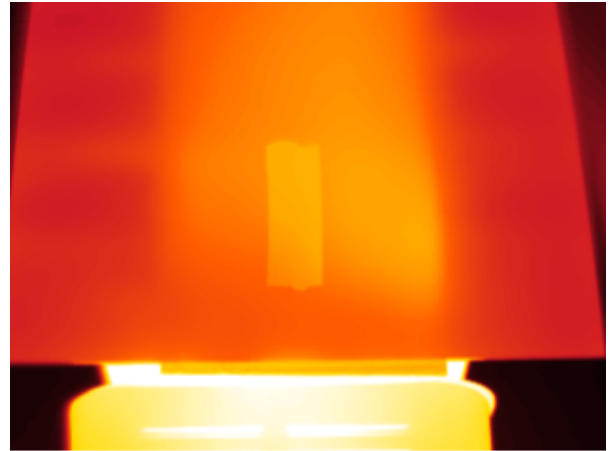
Figure 9. Infrared image of the reflector with electrical tape on the